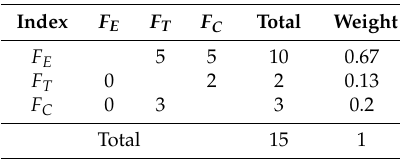
Table 4. Result of pecking-order comparison.